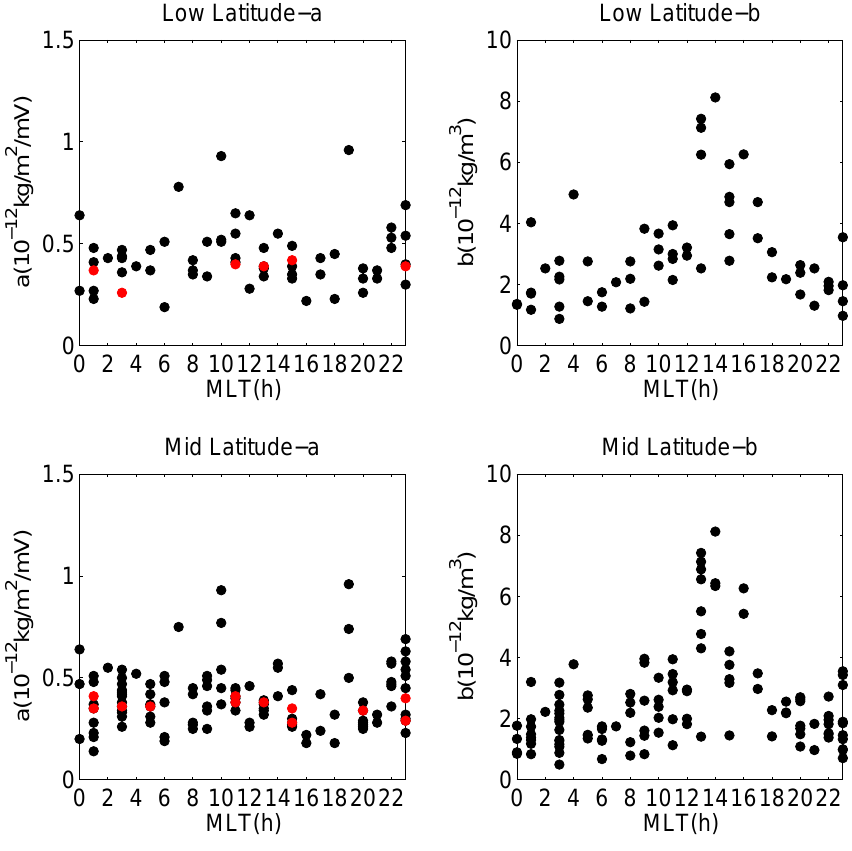
Fig. 4. Same format as Fig. 3, but E m values without truncation are used in Eq. (9).